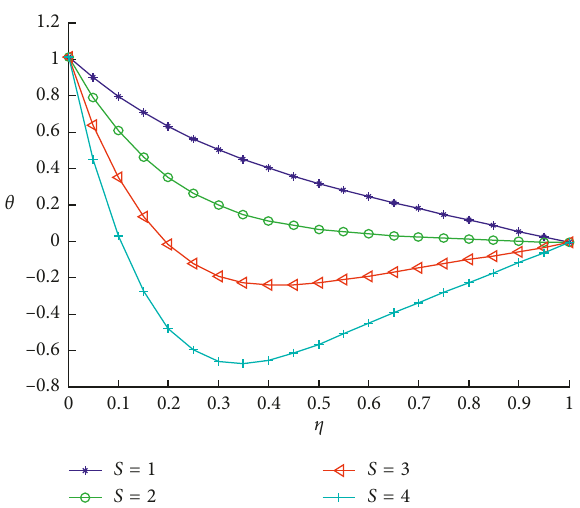
Figure 11: Effect of the squeeze parameter on the temperature profile when A Pr 1 . 0 , and C (cid:31)